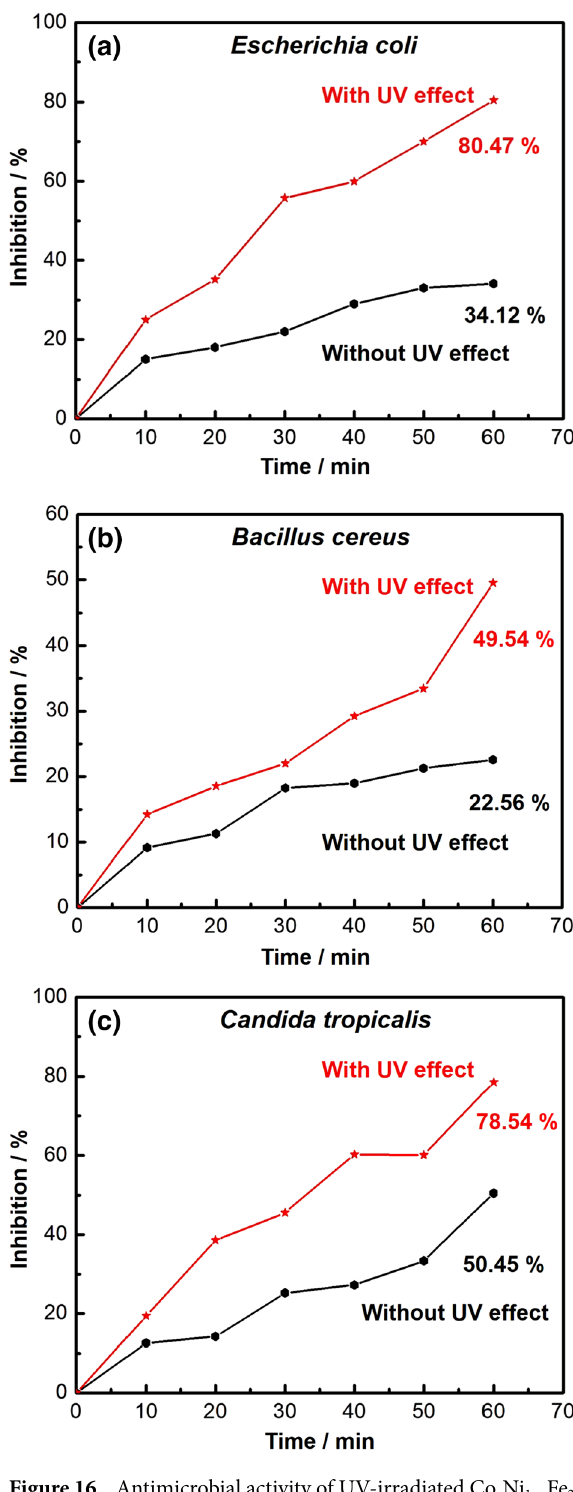
Figure 16. Antimicrobial activity of UV-irradiated Co x Ni 1−x Fe 2 O 4 ; x = 0.9/SiO 2 /TiO 2 /C-dots nanocomposite against different pathogenic microbes: ( a ) Escherichia coli , ( b ) Bacillus cereus and ( c ) Candida